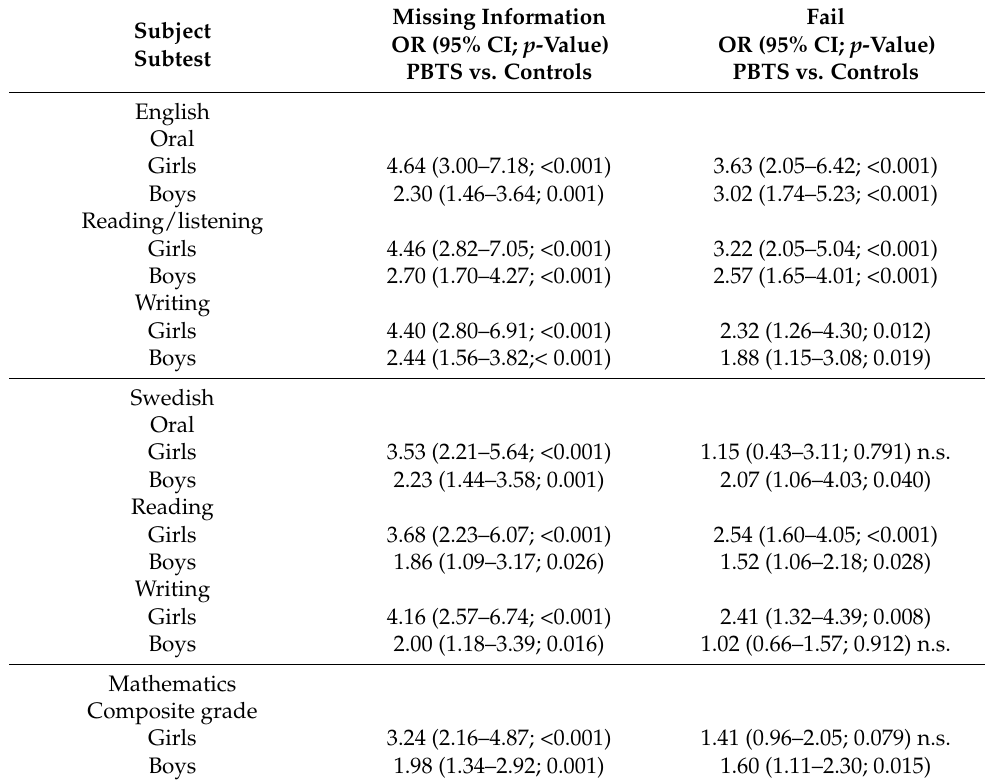
Table 5. Odds ratio (OR), 95% confidence intervals (95% CI) and p -values for missing information and fail in the national tests and subtests in English, Swedish and mathematics year 9 for females and males, respectively. n.s. = not